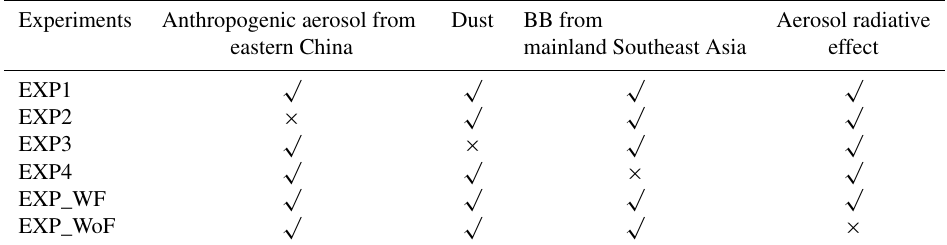
Table 1. WRF-Chem parallel numerical experiment designs. Experiments Anthropogenic aerosol from Dust BB from Aerosol radiative eastern China mainland Southeast Asia